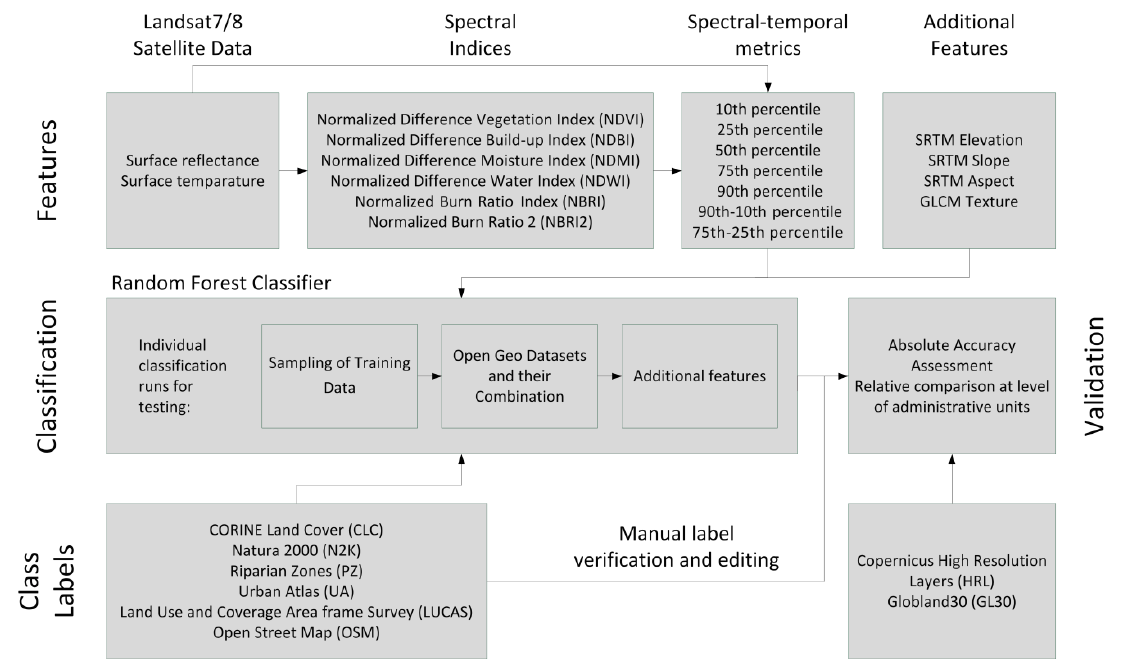
Figure 3. Data used and schematic workflow of this study.